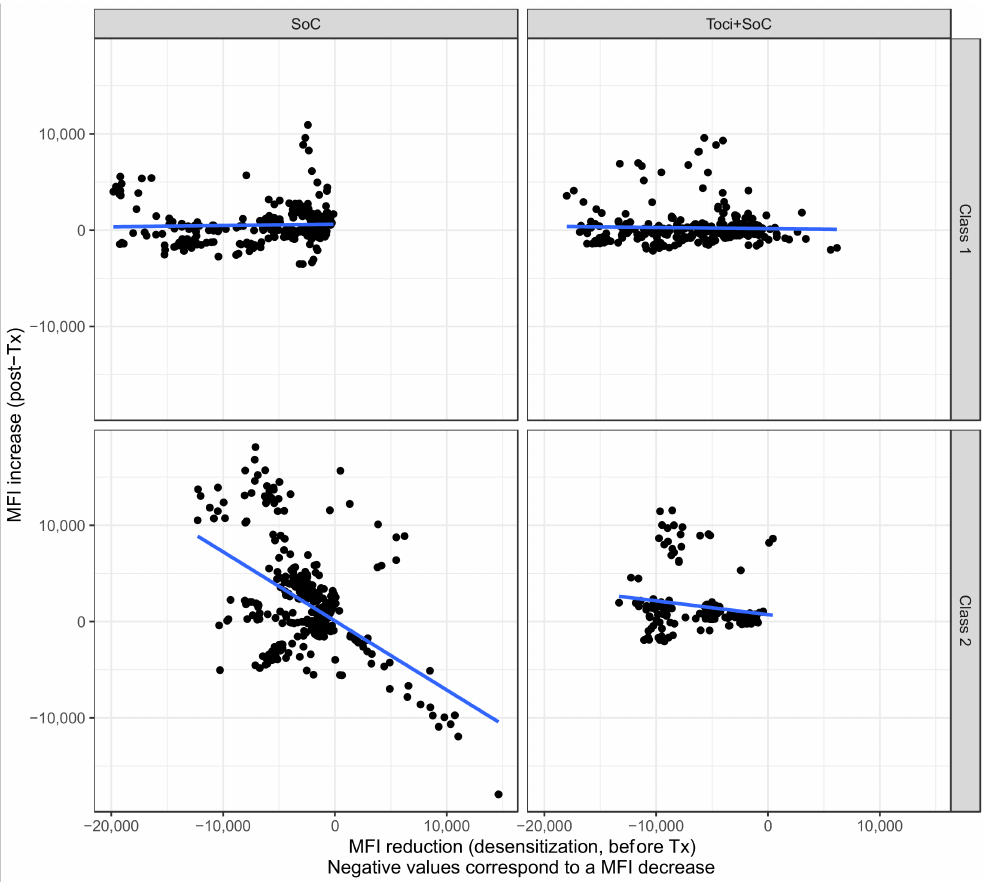
Figure 4. Comparison of pre-transplantation absolute MFI reduction (over the course of desensiti- zation) and post-transplantation rebound for the two desensitization strategies and the two HLA classes. Blue lines are linear regression